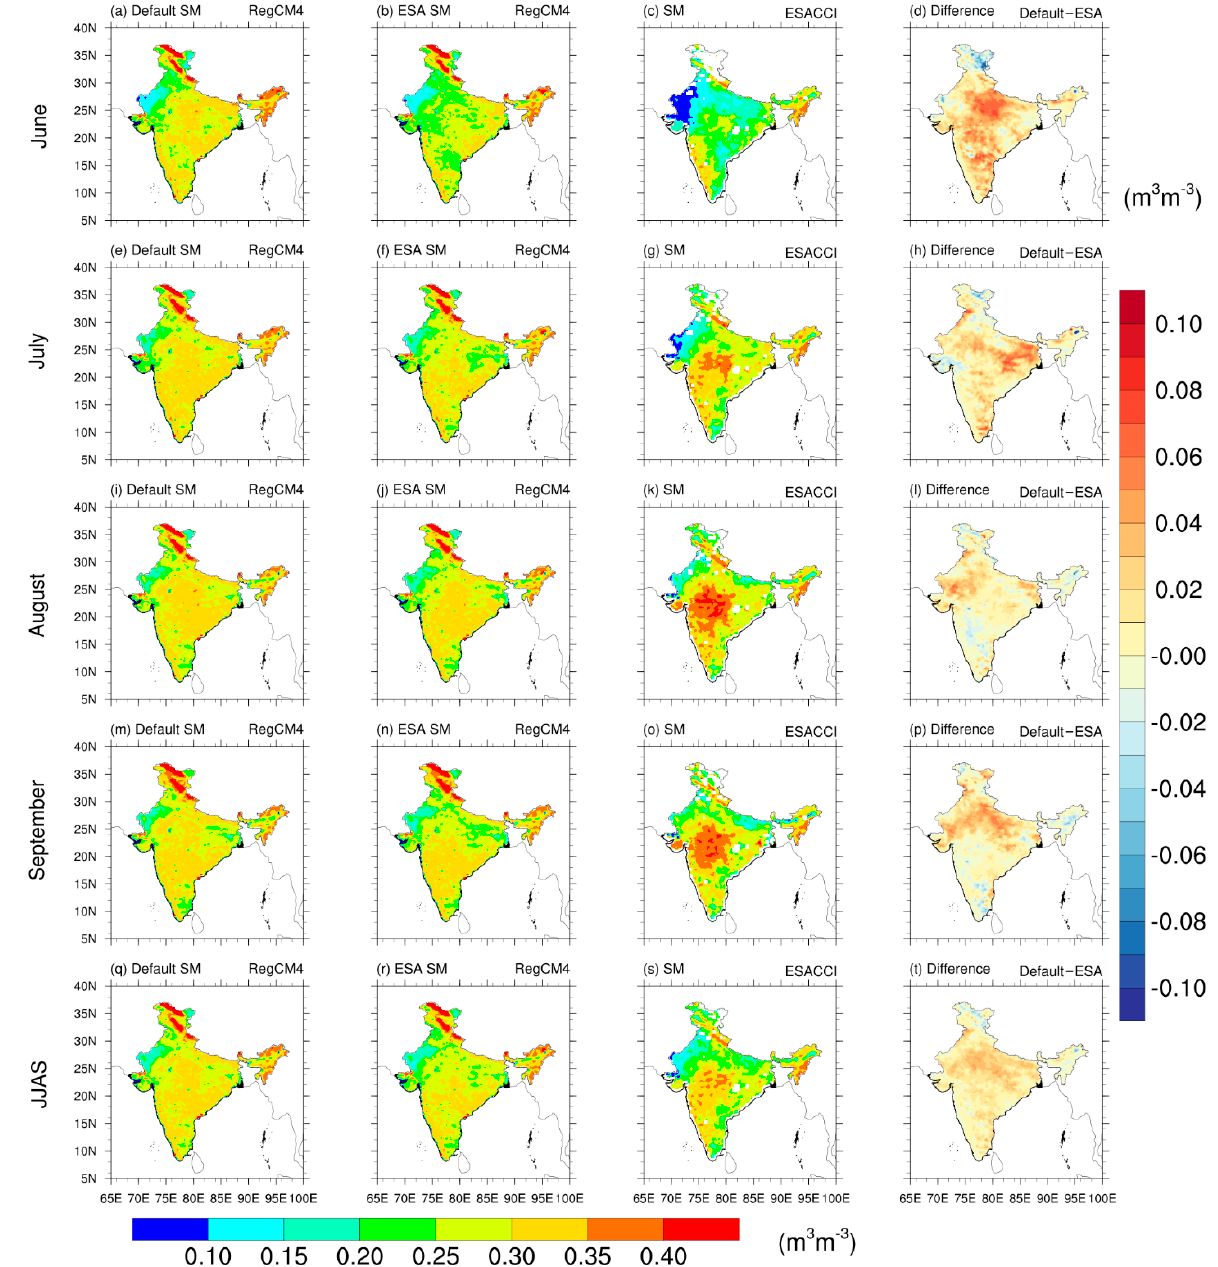
Figure 7. Same as Figure 6, but for the year 2011.